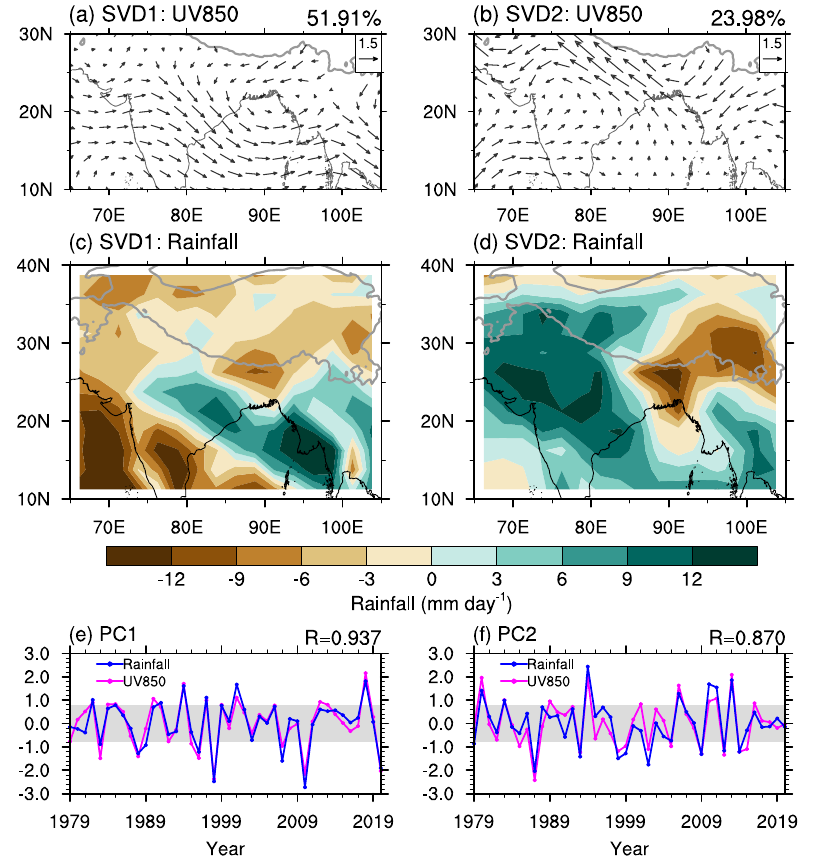
Fig.1|The fi rstandsecondsingularvaluedecompositionmodesofSouthAsian summer monsoon. Spatial patterns of a , b 850-hPa wind (ms − 1 ; vector) and c , d rainfall (mm day − 1 ; shading), and e , f corresponding standardized principal components (PCs) for the fi rst a , c , e and second b , d , f singular value decom- positionmodesinsummer(June-July-August).Theexplainedsquaredcovarianceof